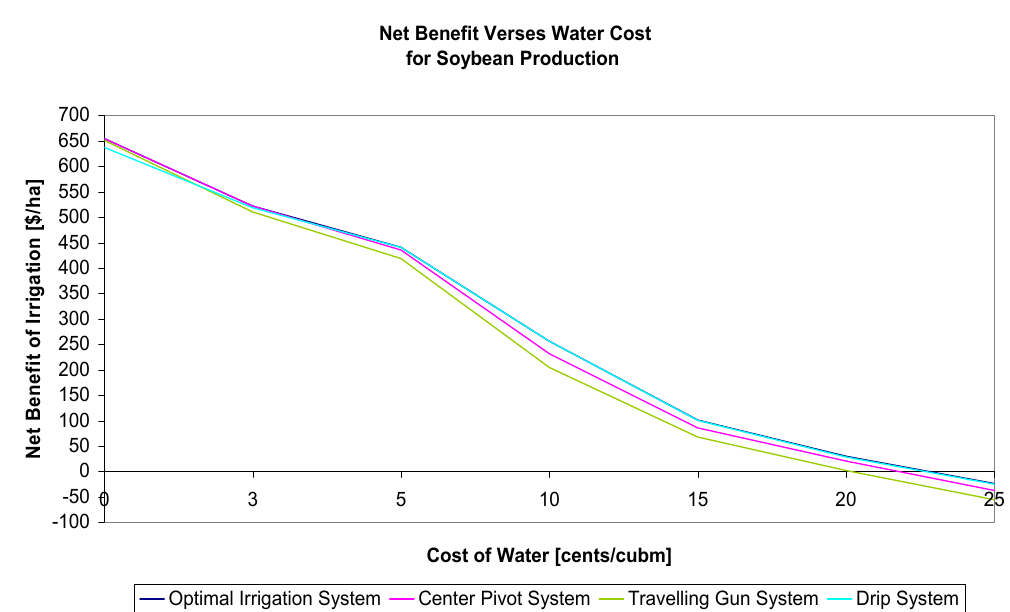
Figure 3. Irrigation system comparison of net benefit versus water cost associated with soybean production.